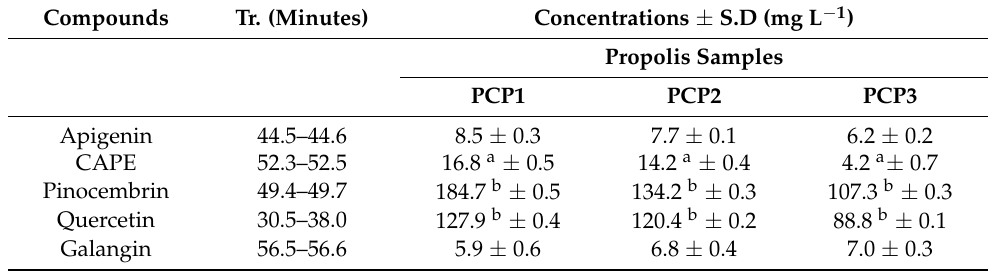
Table 2. Individual polyphenolic compounds quantified by HPC-DAD in three samples of chilean